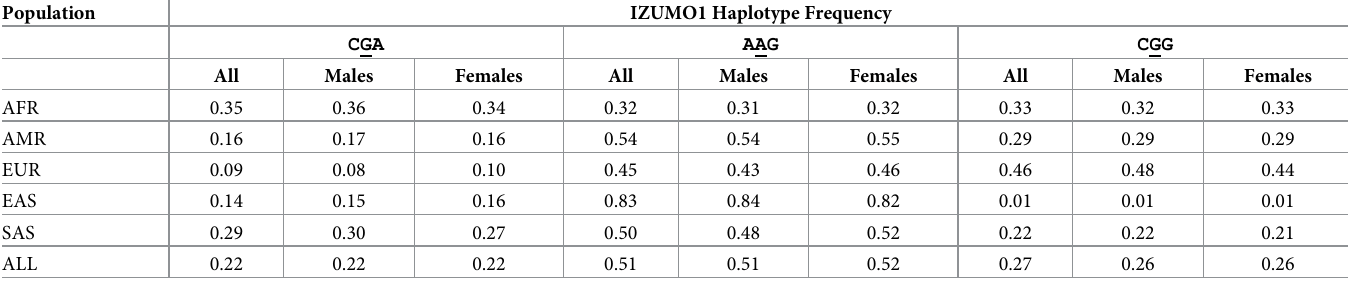
Table 2. The haplotypes and their haplotype frequencies in the IZUMO1 gene (gene ID 284359) for both sexes analyzed together as well as separately in different grouped populations. Population